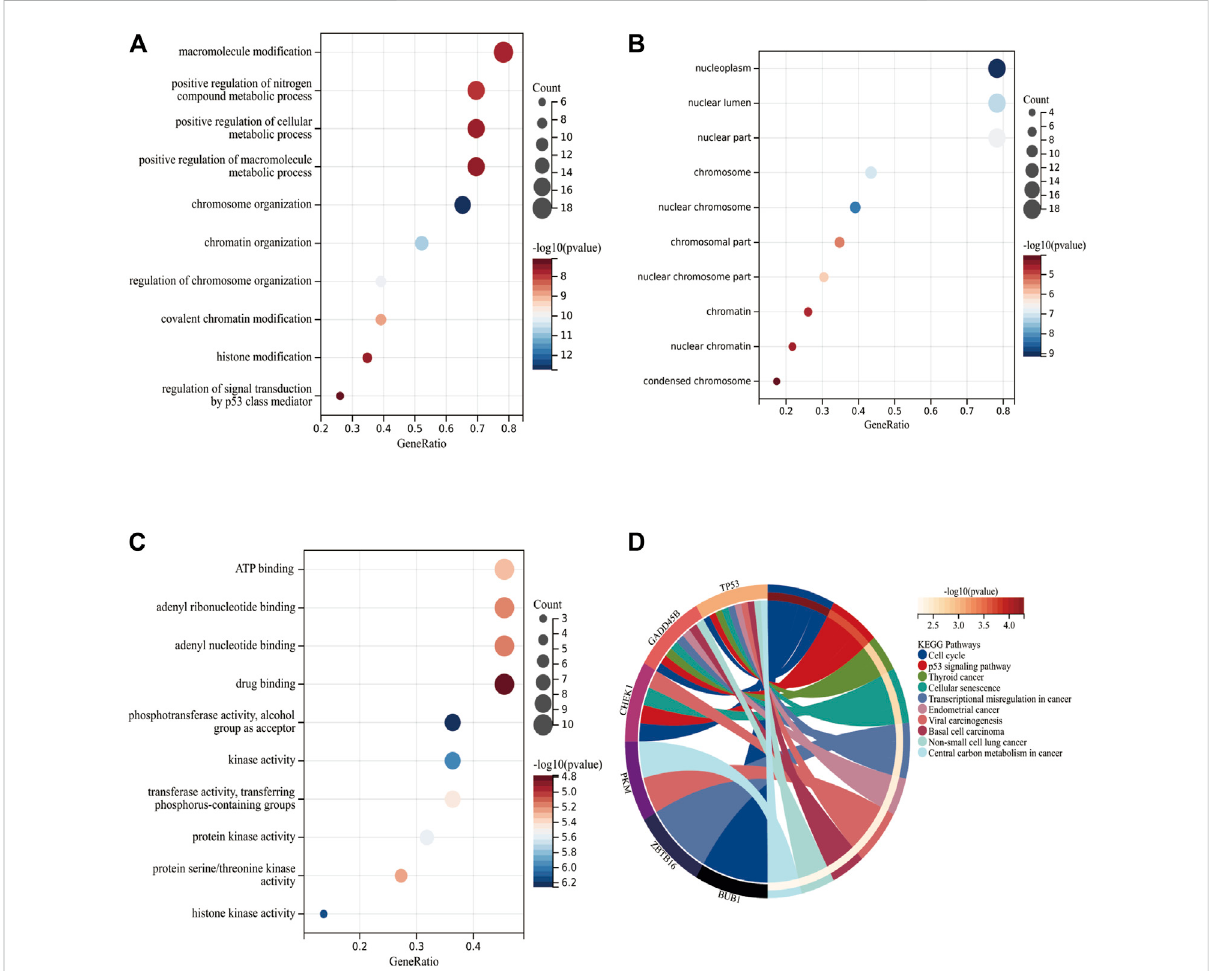
FIGURE 3 Functional enrichment of DECRs. (A – C) Top-10 items for biological process, cellular component, and molecular function, respectively, accordingtotheGOdatabase.Thex-axisandy-axisrepresentthegeneratioandenricheditems,respectively.Thecolorandsizeofeachcirclerefers tothe p -valueandgenecount,respectively. (D) Signaling-pathwayanalysisofDECRsusingtheKEGGdatabase.TheleftandrightpartsrepresentCRs and their enriched signaling pathways, respectively. AbbreviationsDECRs, differentially expressed chromatin regulators; KEGG, Kyoto Encyclopedia of Genes and